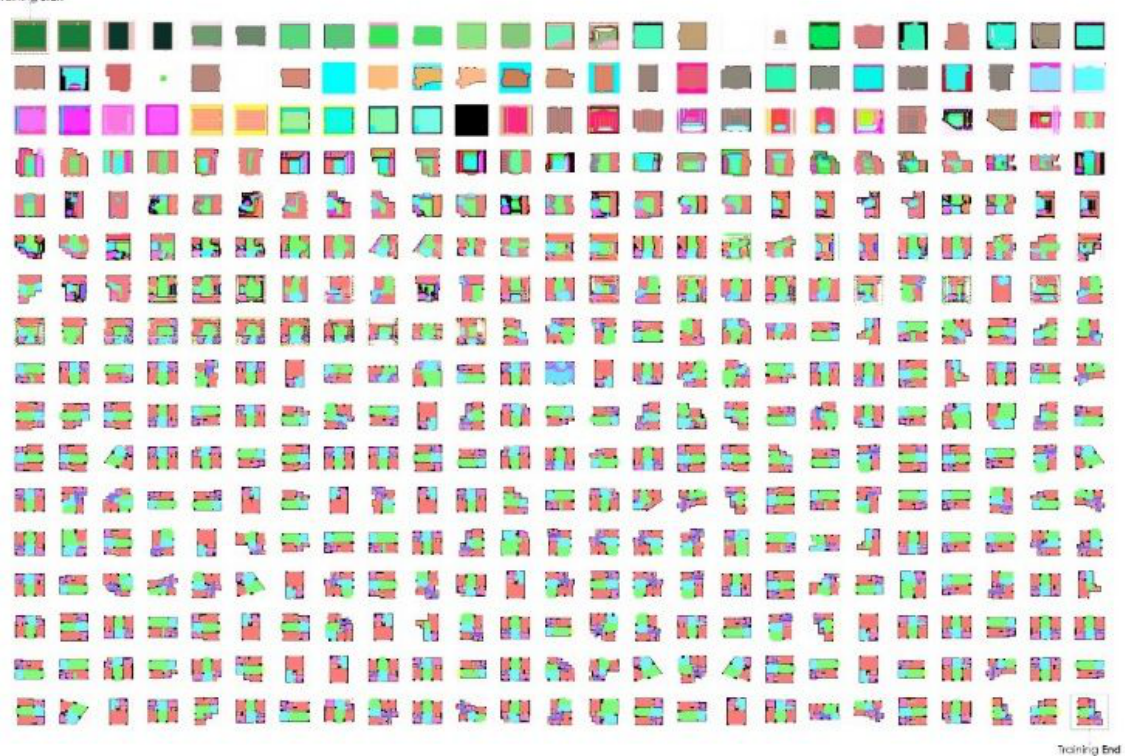
Figure 6. Sequence illustrating how the GAN model increasingly learns to generate floor plans from initial data sets. Each floor plan is a sequential outcome generated during the training of the network. From: Stanislas Chaillou, https://developer.nvidia.com/blog/archigan-generative-stack-apartment-building-design/?